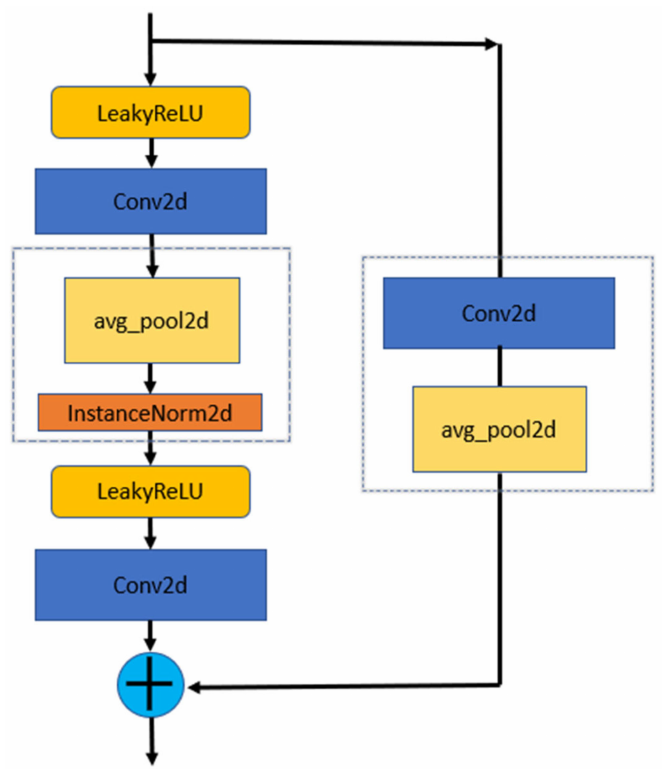
Figure 3. Residual block (the part within the dashed line indicates whether the judgment is executed or